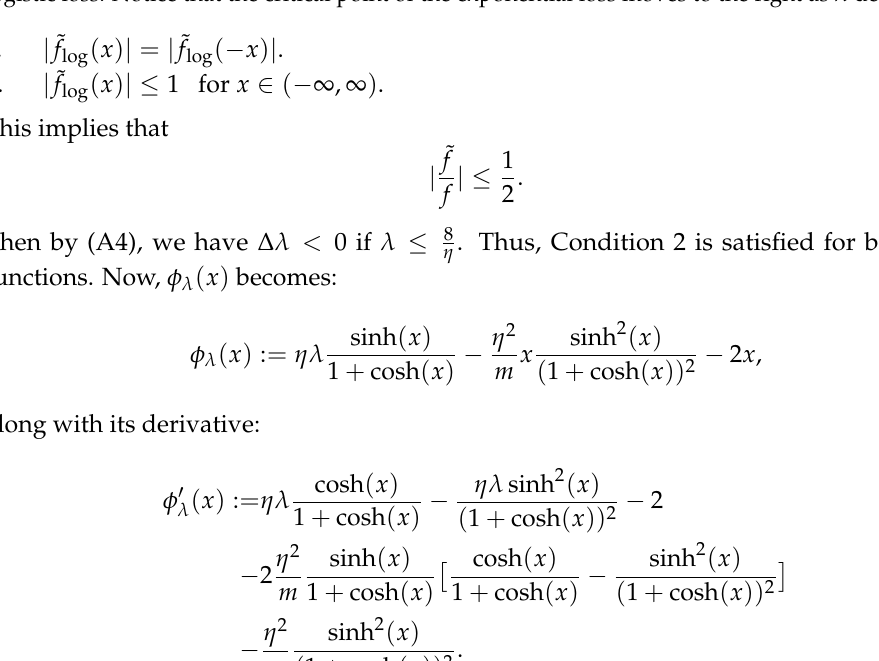
Figure A2. Different colours represent different λ (NTK) values. ( a ) Graph of φ λ ( x ) equipped with the exponential loss. ( b ) Graph of the derivative of φ λ ( x ) equipped with the exponential loss. ( c ) Graph of φ λ ( x ) equipped with the logistic loss. ( d ) Graph of the derivative of φ λ ( x ) equipped with the logistic loss. Notice that the critical point of the exponential loss moves to the right as λ